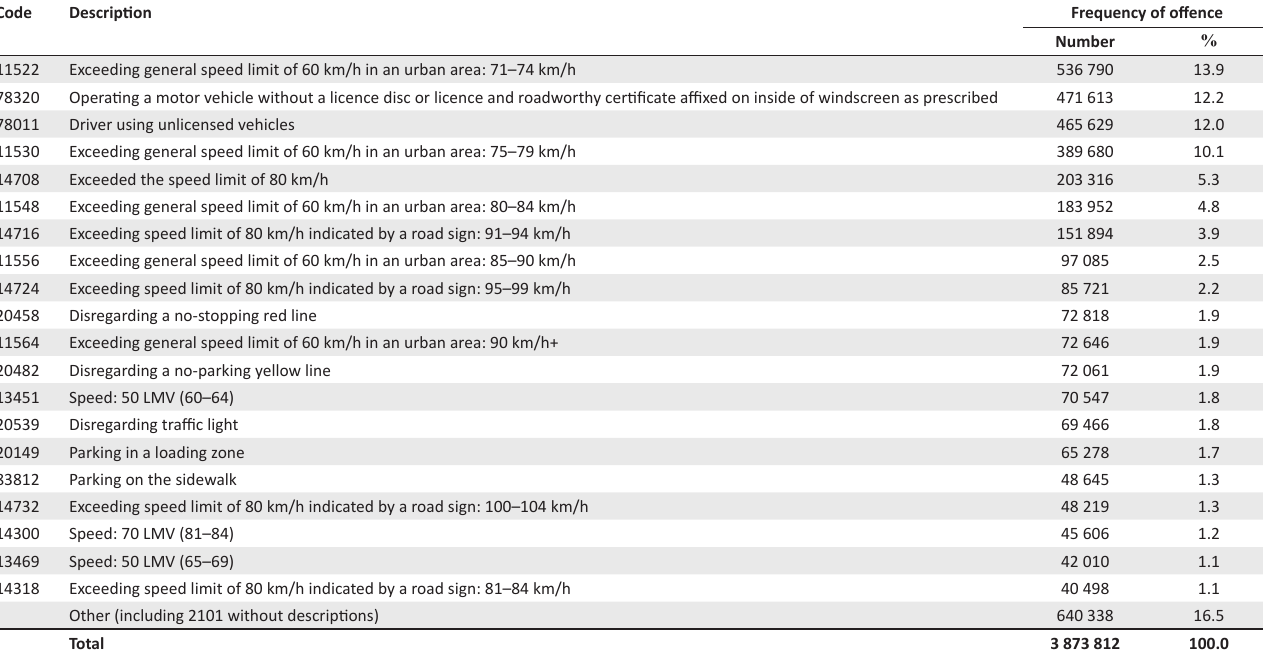
TABLE 5: The 20 traffic offences for which most fines were issued in the City of Cape Town (July 2014–July 2016). Code Description